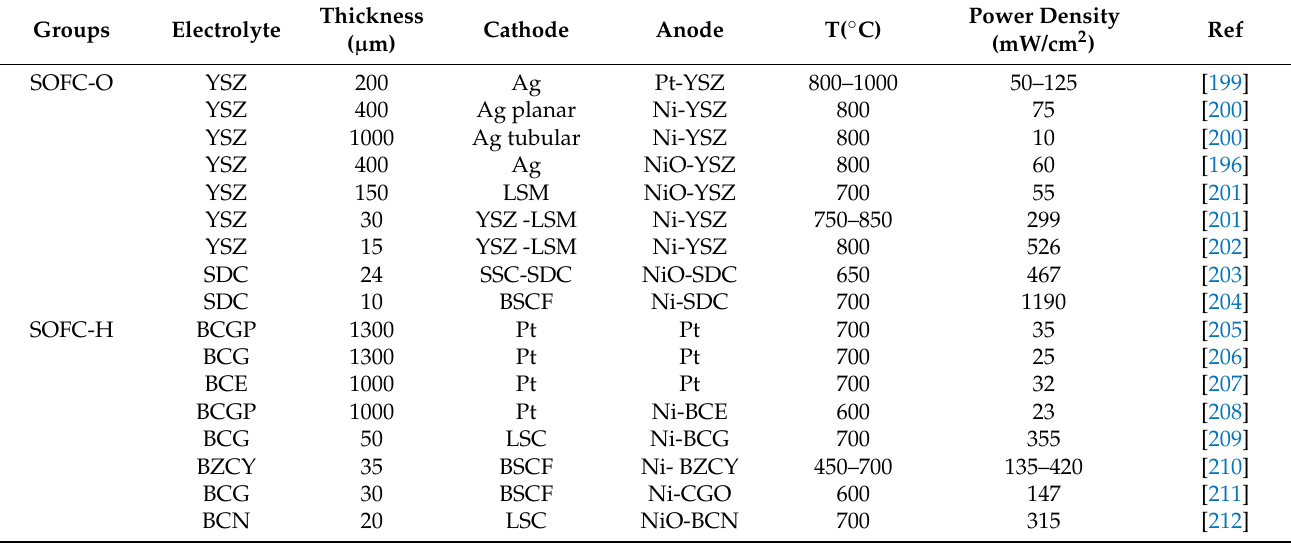
Table 10. Summarization of previous research on SOFC for ammonia